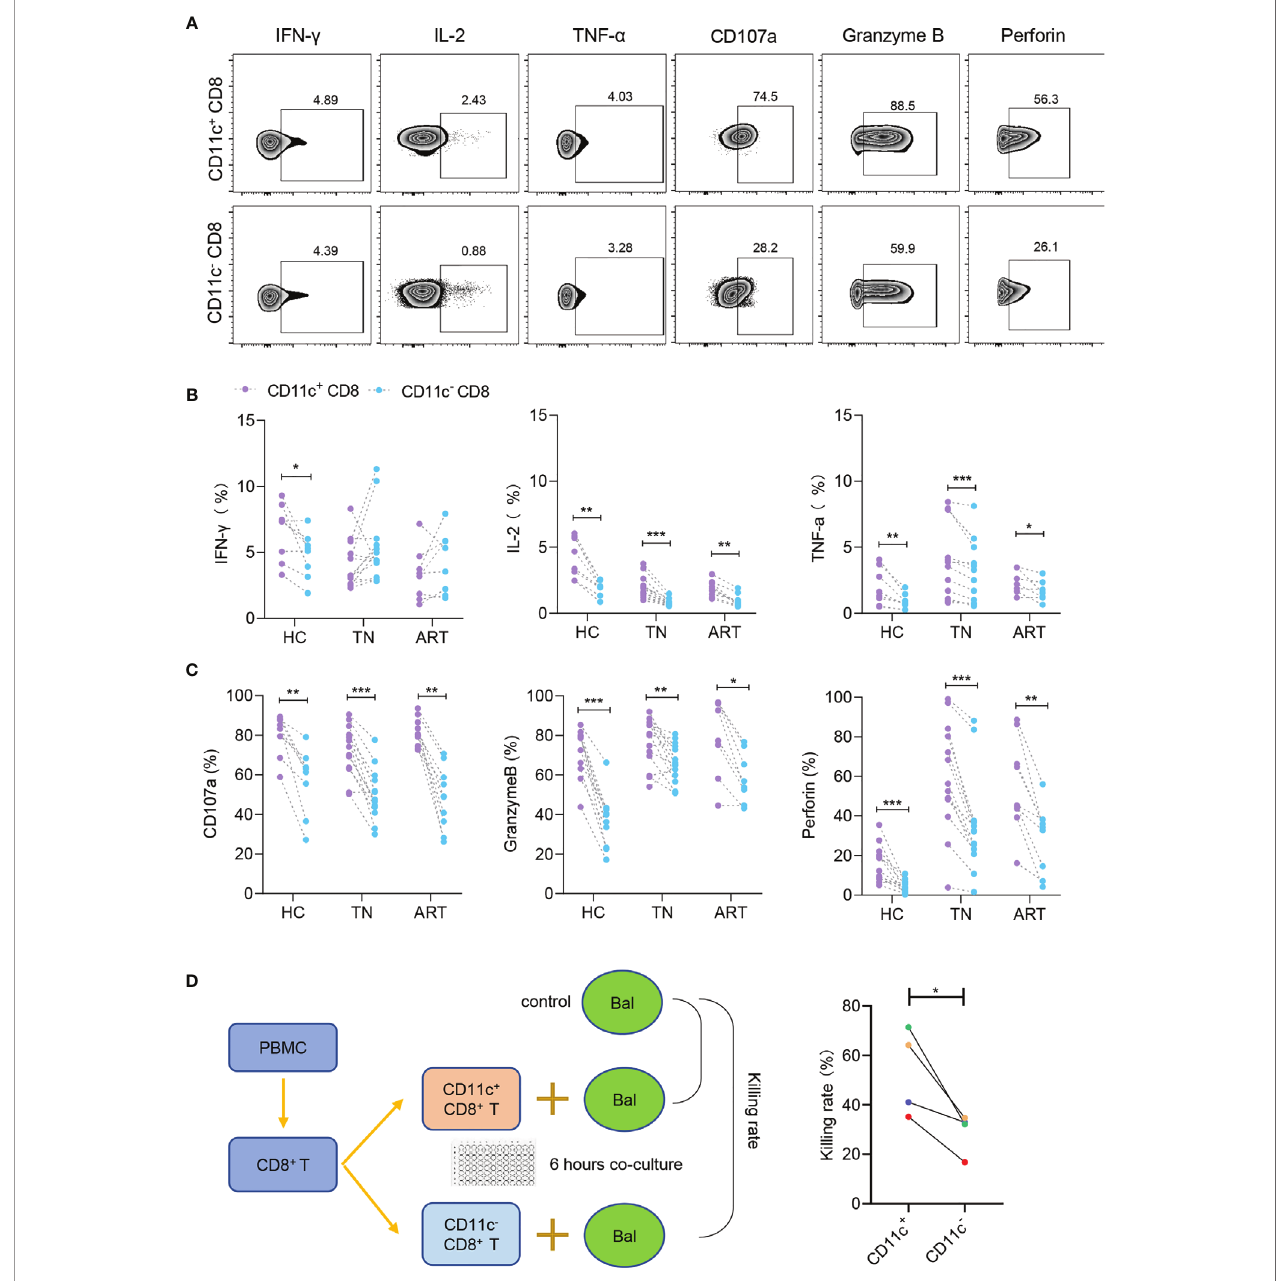
FIGURE 4 | CD11c + CD8 + T cells have strong secretory and cytotoxic capacity during HIV-1 infection. (A) Representative fl ow cytometry plots showing the staining of indicated cytokines and cytotoxicity-related molecules. The numbers indicate the percentage of gated cells. Expression of cytokines (B) and cytotoxicity-related molecules (C) in CD11c + and CD11c - CD8 + T cells. (D) Schematic of killing assay and killing rates of CD11c + and CD11c - CD8 + T cells to target cells. * P < 0.05; ** P < 0.01; *** P <